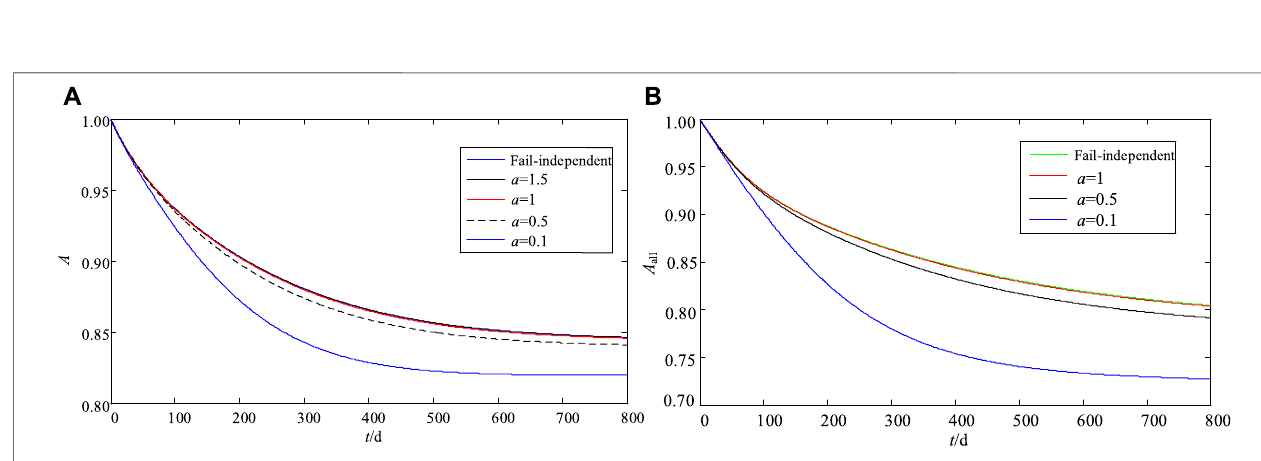
FIGURE10| Availabilitycurvesfor differentfailure-relatedstrengths. (A) Availability curve ofthecombiner box withdifferentfailure-related strengths. (B) Availability curve of the system with different failure-related strengths.